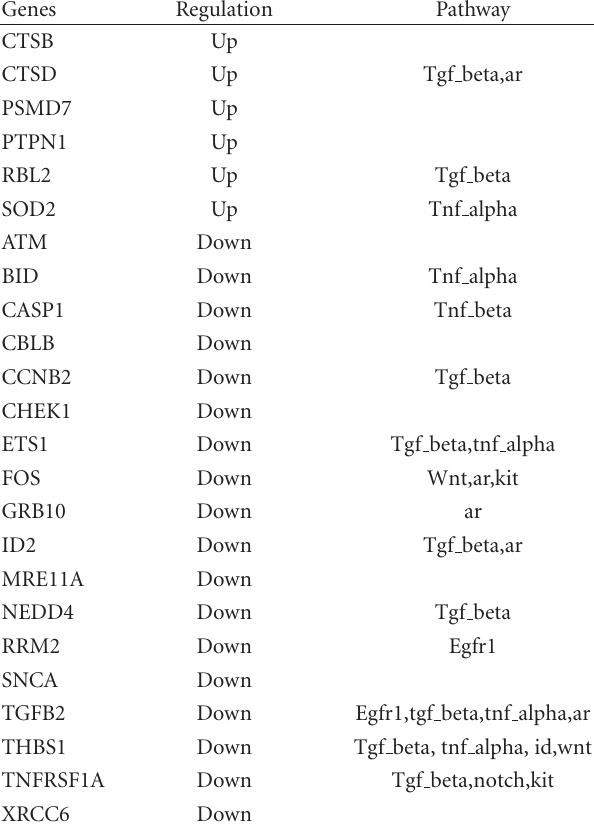
Table 4: The important genes of network associated with genes in cancer pathways. These genes are obtained by combining three sets of hub genes from interaction network, articulation nodes, and from the minimum spanning tree of G p . We show the specific pathway a gene is involved